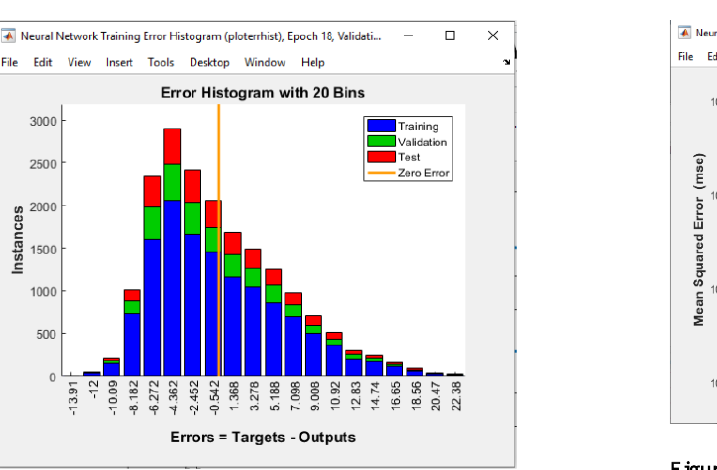
Figure 8 . Error histogram, after validation of training, the zero error shows there is no negative feedback